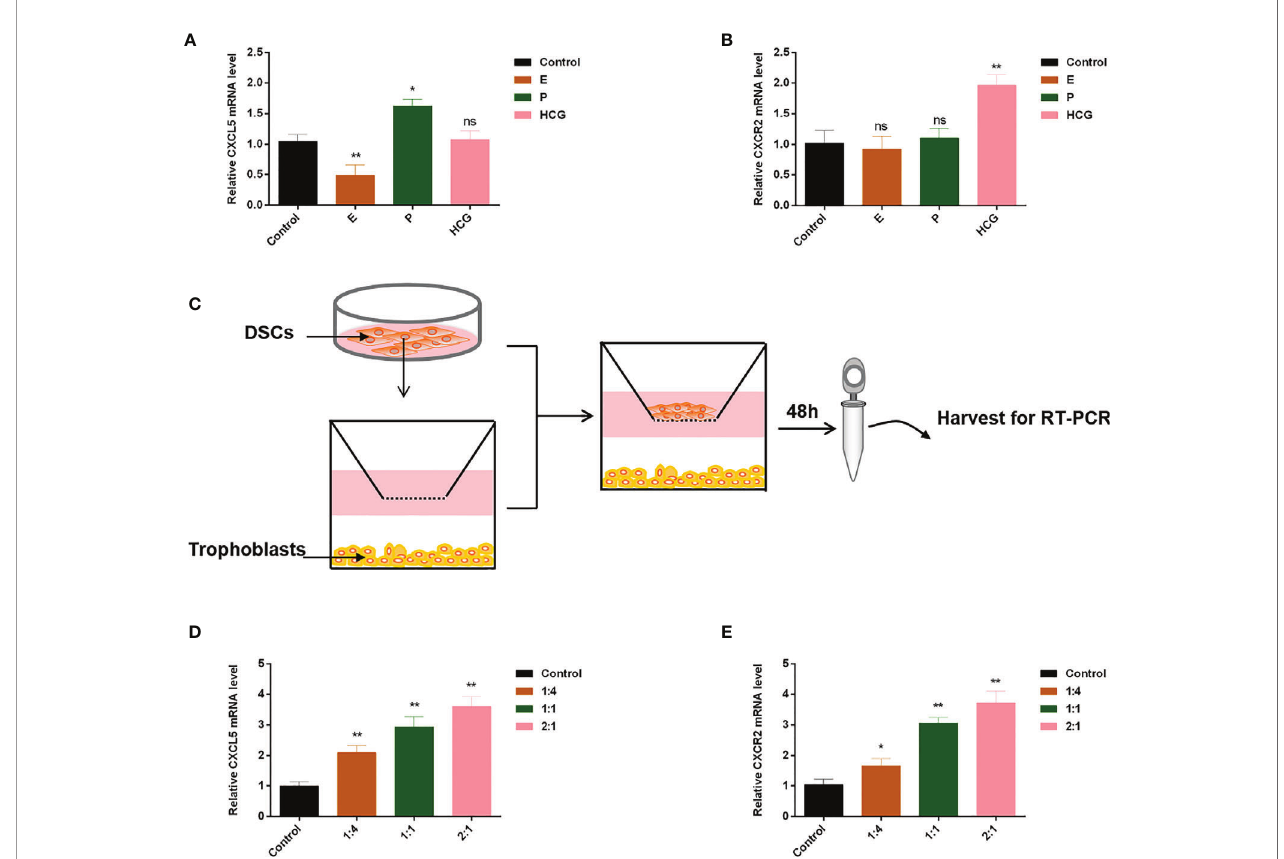
FIGURE 6 | E, P, HCG, and DSCs regulate CXCL5/CXCR2 expression of trophoblast cells. HTR-8 cells were treated with E, P, and HCG at the indicated concentrations for 48 h. (A, B) RT-PCR was used to detect the expression levels of CXCL5 and CXCR2. (C) A co-culture system of HTR-8 cells and DSCs was taken for 48 h. (D, E) RT-PCR was used to investigate the impact of DSCs on CXCL5 and CXCR2 expression of trophoblast cells. Graphs show the mean ± SD. Results are reported as fold change compared with the control group (* p < 0.05, ** p < 0.01, ns, no signi fi cant difference, p > 0.05). E, estrogen; P, progesterone; HCG, human chorionic gonadotropin; DSCs, decidual stromal cells; RT-PCR, quantitative real-time